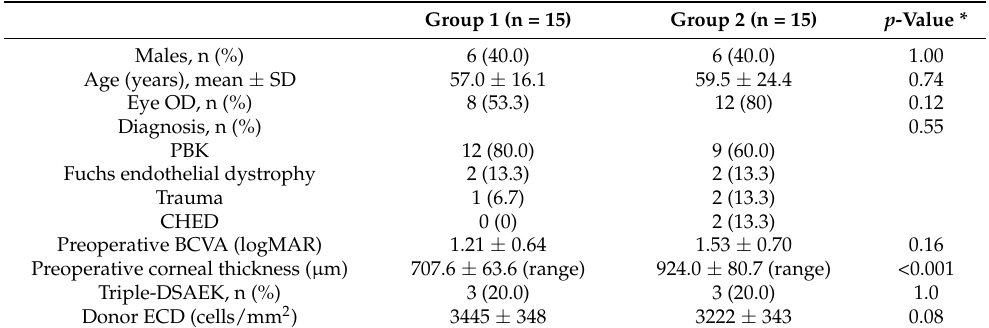
Table 1. Baseline characteristics of patients who underwent Descemet stripping automated endothe- lial